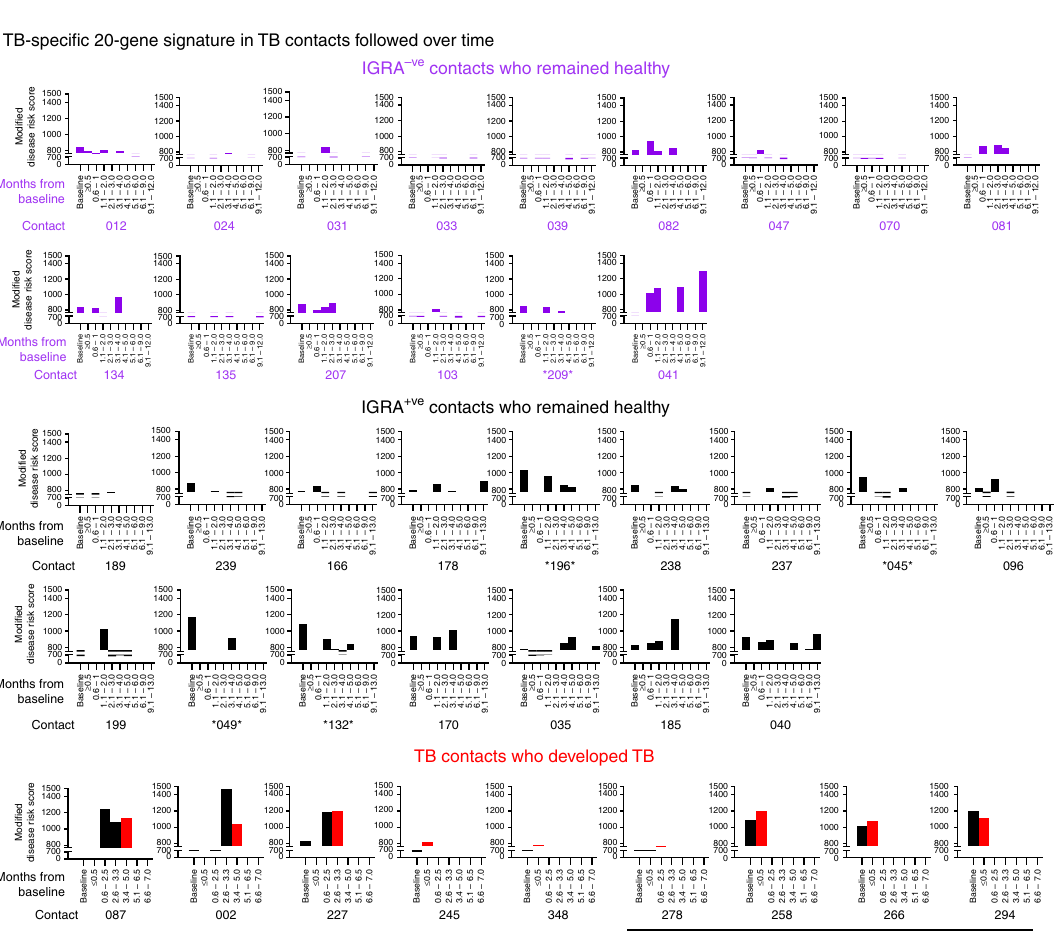
Fig. 10 Blood transcriptional pro fi le of TB contacts followed over time. a Schematic representing active TB patients from the Leicester cohort and their contacts followed over time. Purple, black and red represent IGRA − ve (controls), IGRA + ve (LTBI) and active TB patients, respectively. b Bar plots depicting the modi fi ed disease risk scores using the TB-speci fi c 20-gene signature in TB contacts who remained IGRA − ve and did not develop TB ( n = 15), TB contacts who remained IGRA + ve and did not develop TB ( n = 16) and TB contacts who developed TB during the study ( n = 9). For TB contacts who developed TB during the study, the time point when the contact was diagnosed with active TB in the clinic is represented by a red bar. Baseline in the barplot is set at 766.64, average of all Baseline time point modi fi ed disease risk scores from all IGRA − ve contacts ( n =